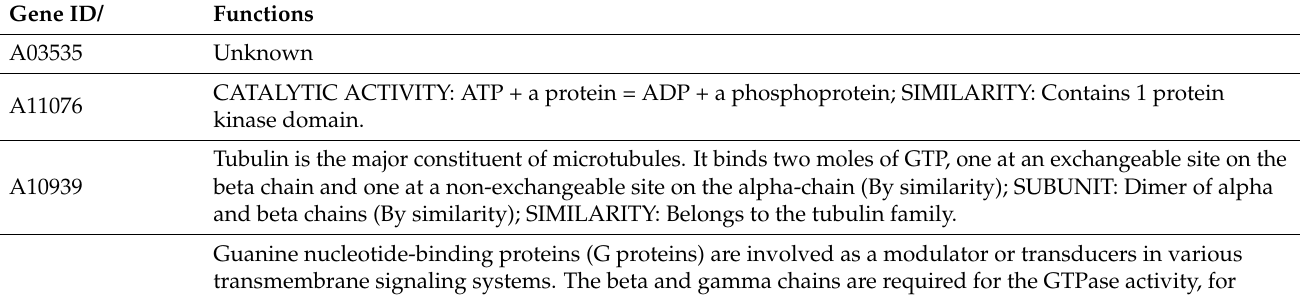
Table 5. Gene product name and functions of DFVF 10